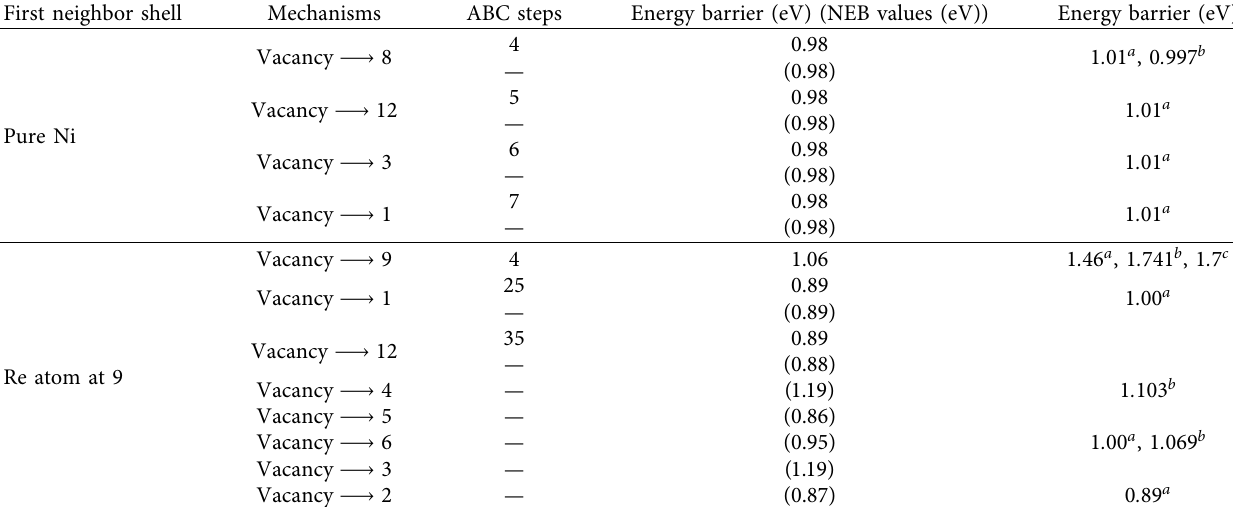
Table 1: Elementary vacancy diffusion pathways observed by the ABC method and their corresponding energy barriers. The position numbers are depicted in Figure 1. The corresponding energy barriers calculated using classical NEB methods are reported in parentheses in the unit of electron volt. The values in the last column are taken from a [12], b [43], and c